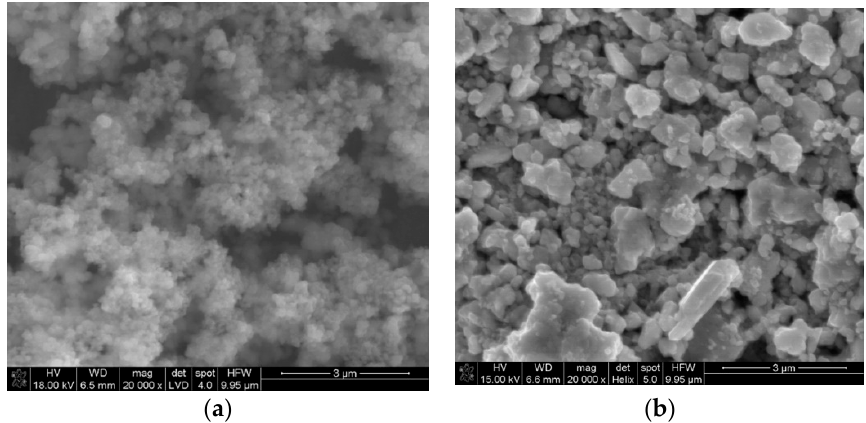
Figure 1. SEM scans of ( a ) hydrous RuO 2 and ( b ) anhydrous RuO 2 .